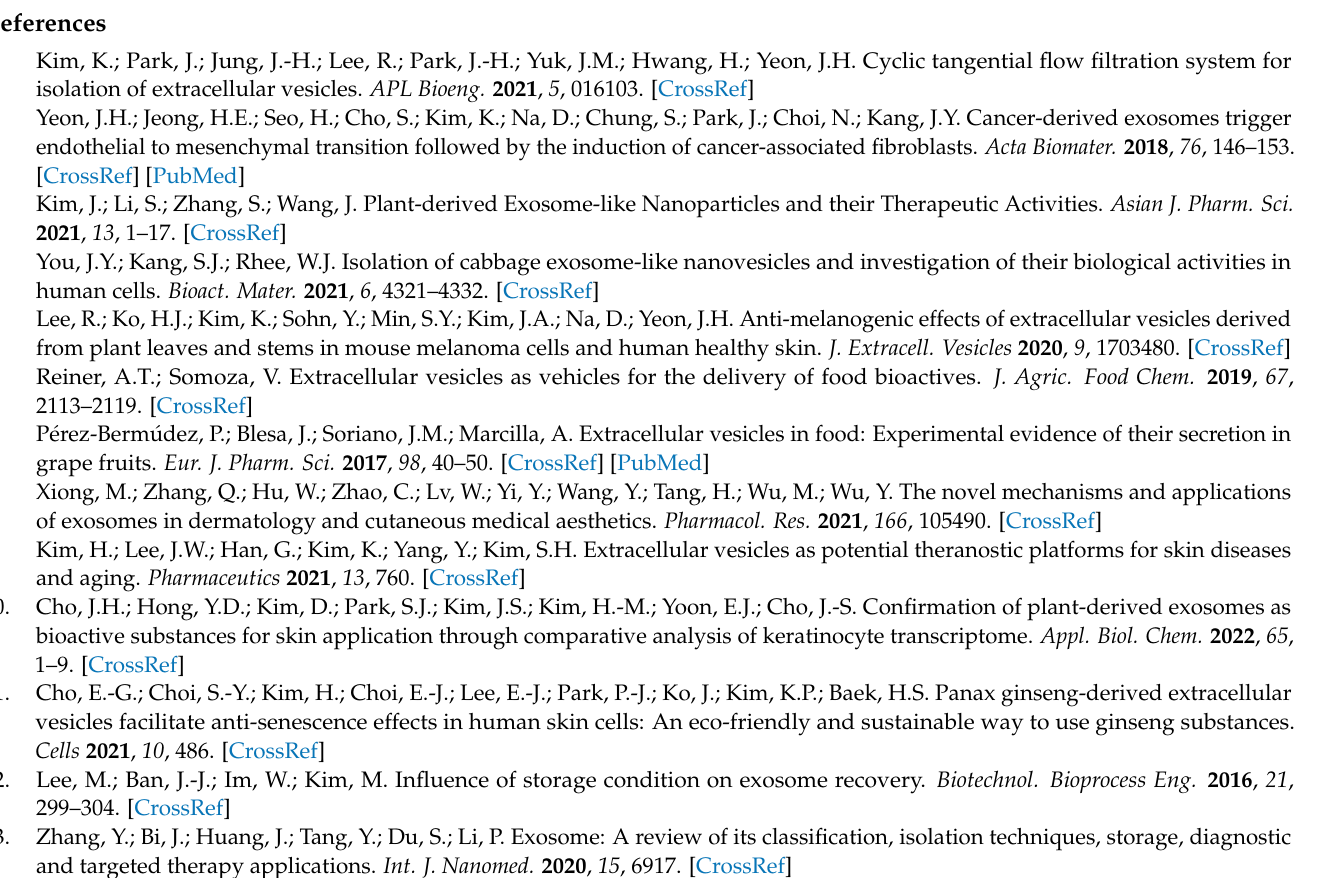
BG using at 45°C during 4 weeks. Figure S2: pH tests of LEVs-1,3BG over time. Figure S3: PDI values of LEVs, LEVs-1,3BG, and LEVs-TMO. Figure S4: Size distribution of LEVs-1,3BG over time under different temperature. Figure S5: Zeta potentials over time under different temperatures. Figure S6: Cellular uptake for LEVs under different temperatures. Table S1: Physical characteristics of LEVs. Table S2: Physical characteristics of mixture of LEVs and 1,3 BG. Table S3: Physical characteristics of mixture of LEVs and